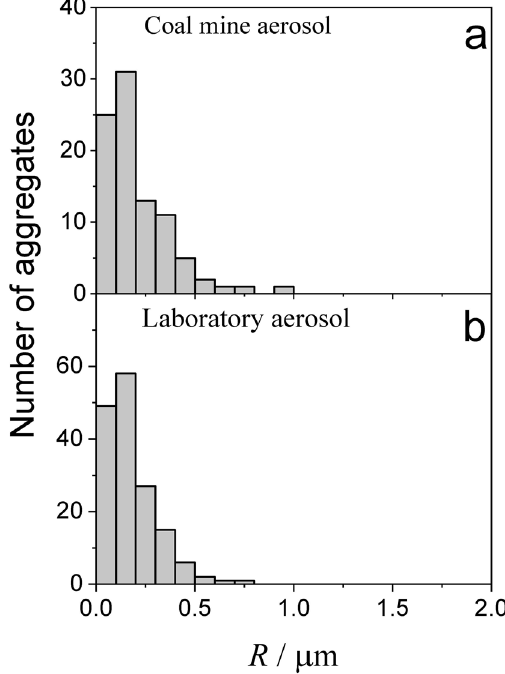
Fig. 6 Aggregate radius distribution: a coal mine aerosol, b labora- tory aerosol ( T d = 170 K)